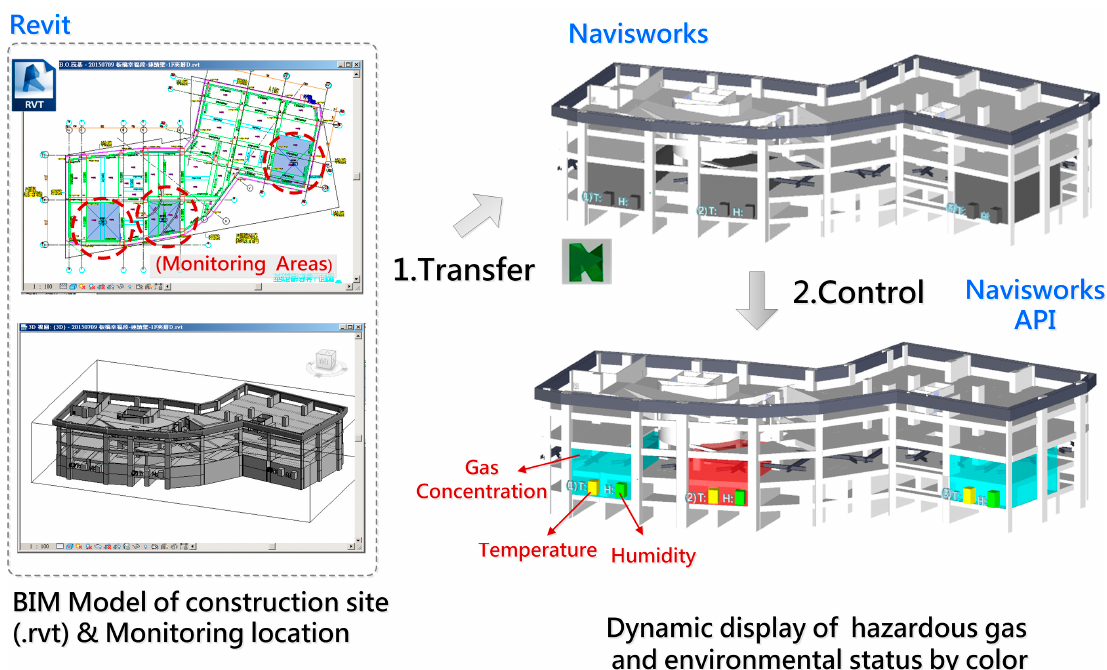
Figure 10 . Construction of the BIM model and components. Figure 10. Construction of the BIM model and